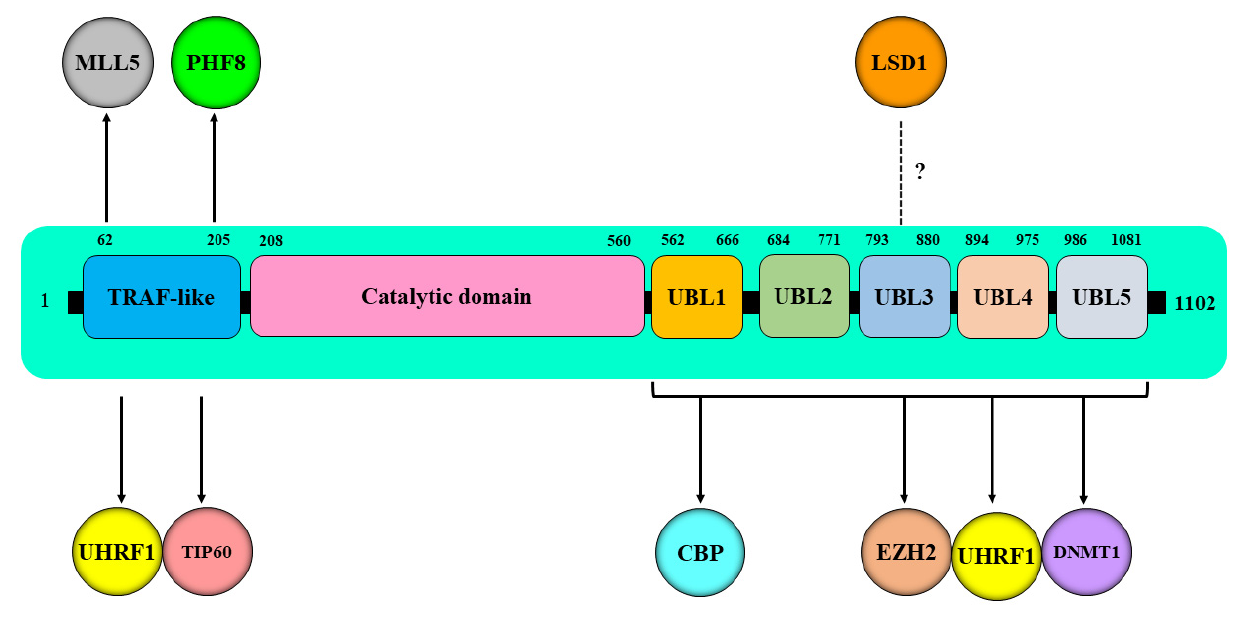
Figure 2. Schematic representation of interactions of HAUSP domains with various epigenetic players. HAUSP via its TRAF-like domain interacts with the ubiquitin-like containing plant homeodomain (PHD) and an interesting new gene (RING) finger domains 1 (UHRF1) [38], histone acetyltransferase TIP60 [50], the histone lysine methyltransferase MLL5 (Mixed-lineage leukemia 5) [53] and the lysine specific histone demethylase PHF8 (PHD finger protein 8) [56]. HAUSP through the C-terminal region which covers its five UBL domains can interact also with UHRF1 [48], histone acetyltransferase CBP (CREB binding protein) [51], histone methyltransferase EZH2 [52] and DNA methyltransferase 1 (DNMT1) [38]. HAUSP can also bind to LSD1 but the interaction site is not yet known [54].